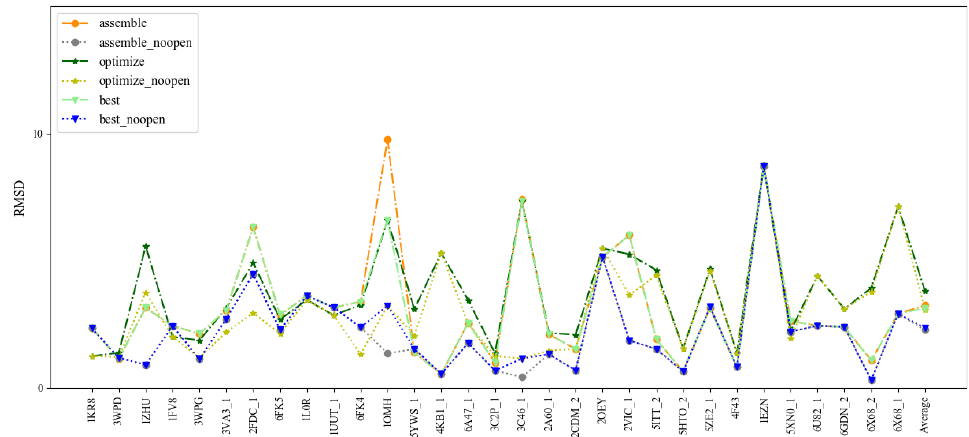
Figure 1. Comparison of the prediction accuracies (all-atom RMSDs) of 3dDNA for the assembled, optimized, and best structures of 31 single-chain DNAs with or without open loops.